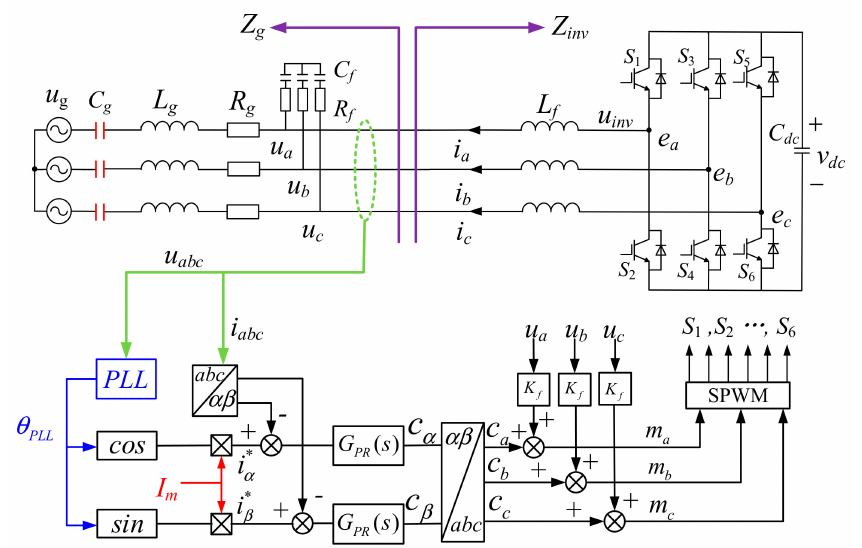
Figure 1. Configuration and control structure of the